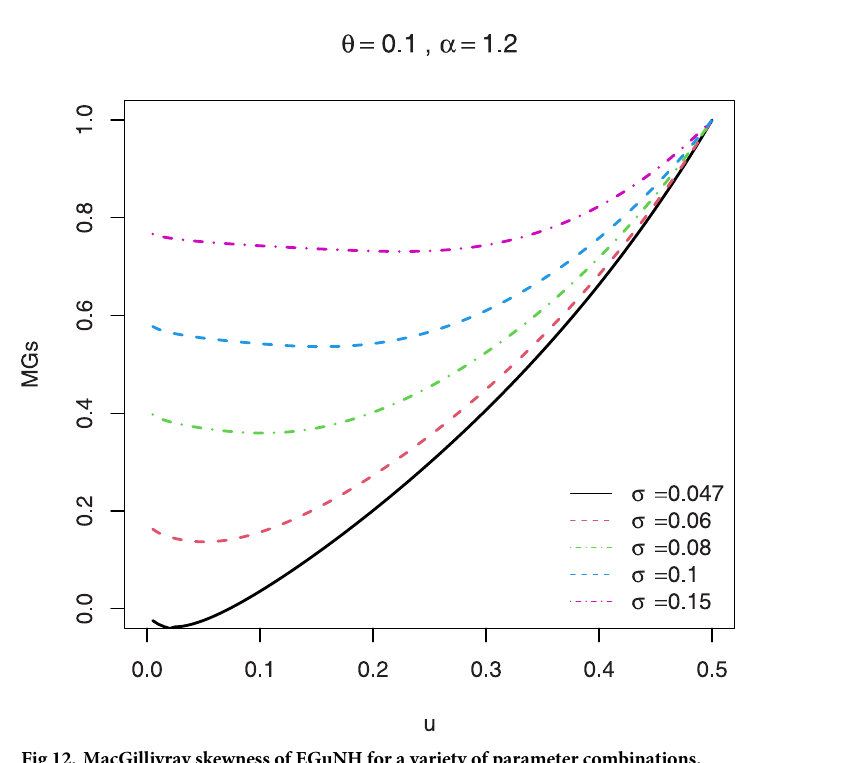
Fig 12. MacGillivray skewness of EGuNH for a variety of parameter combinations.